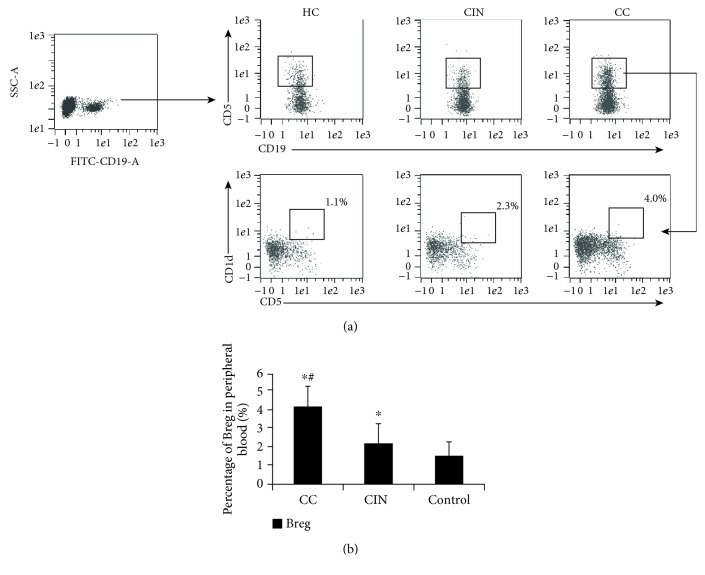
Breg cell flow cytometry. Flow cytometry was performed to detect the Breg cell percentage. (a) Representative flow cytometry results for the gating strategy of CD19+CD1d+CD5+ Breg cells. (b) Breg percentage in normal control, CIN, and cervical cancer groups. ∗P < 0.05 compared with the control group; #P < 0.05 compared with the CIN group.